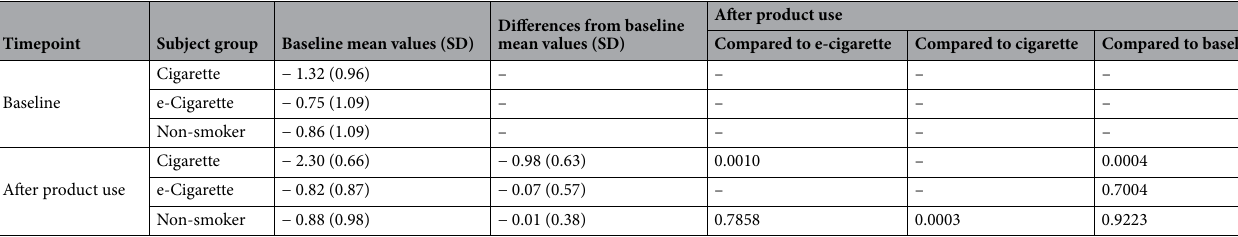
Table 5. Breath hedonic scale values before and after product use. Mean and SD values at baseline and following cigarette or ePen 3 e-cigarette use. NS values were collected at baseline and 10 ± 5 min later.